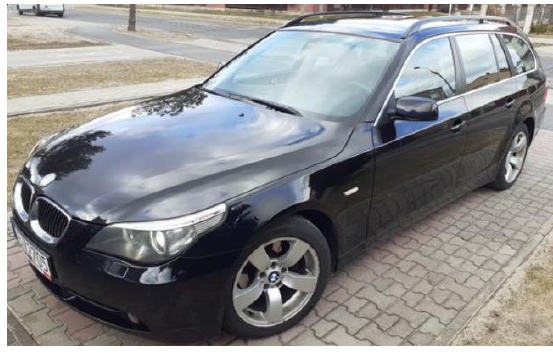
Fig. 3. Tested vehicle BMW E61